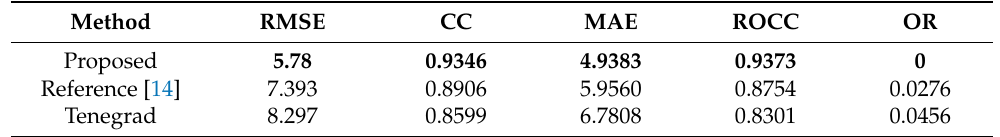
Table 3. Performance evaluation of the three methods.